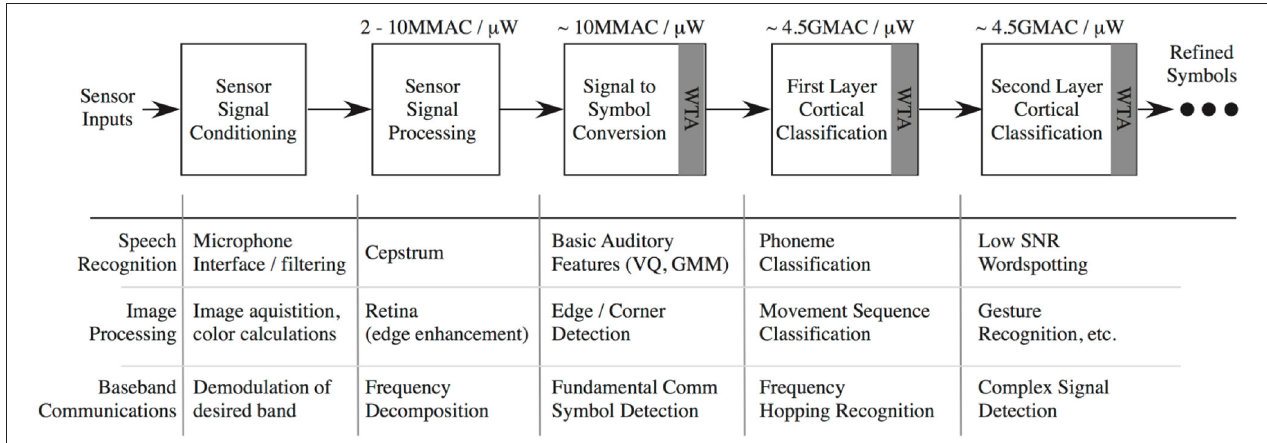
FIGURE 30 | Typical signal processing chain using configurable analog approaches and neural-based